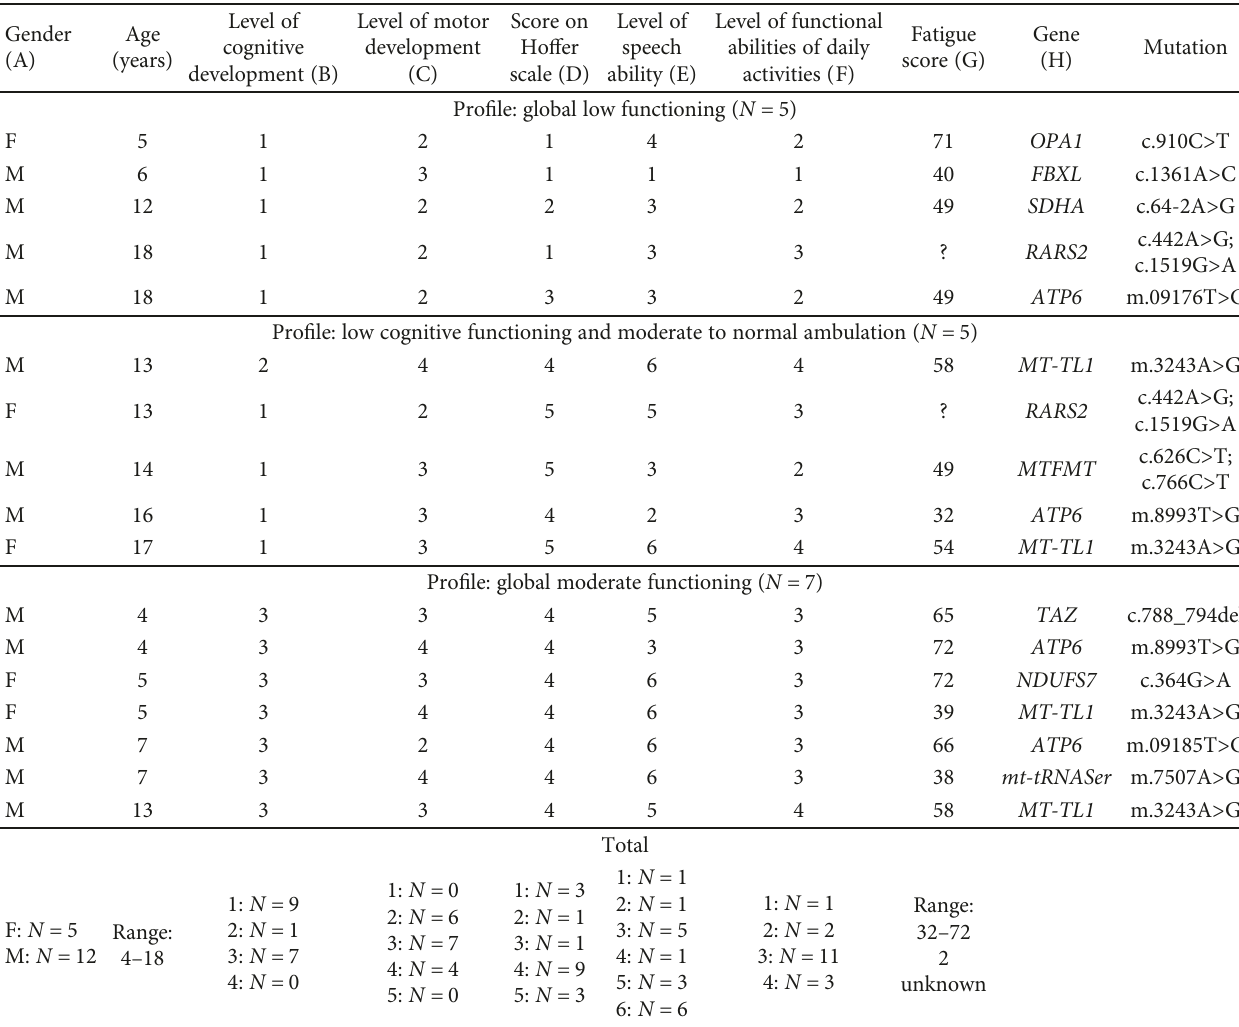
Table 1: Clinical and genetic characteristics of the